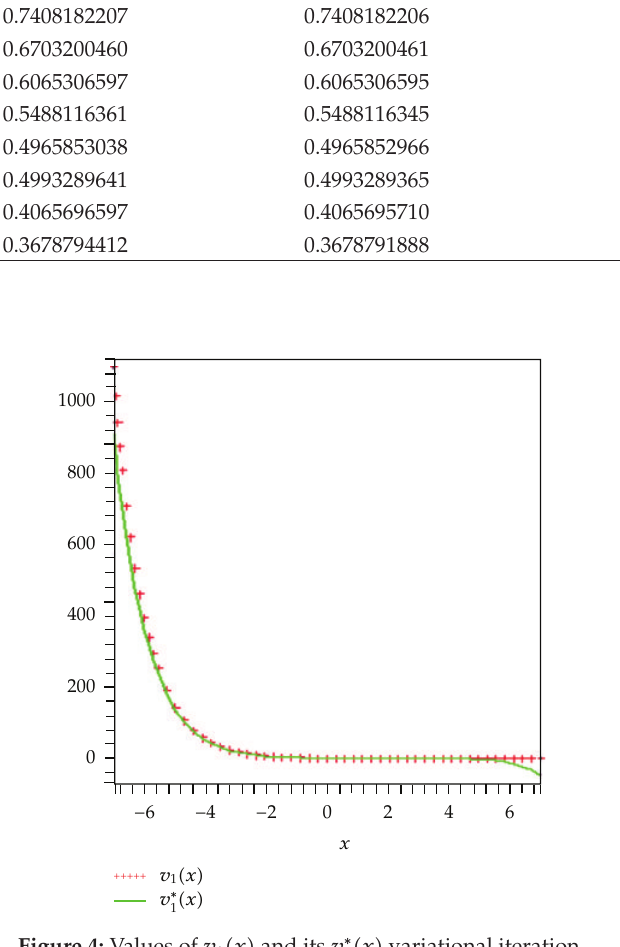
Figure 4: Values of v 1 (cid:3) x (cid:4) and its v ∗